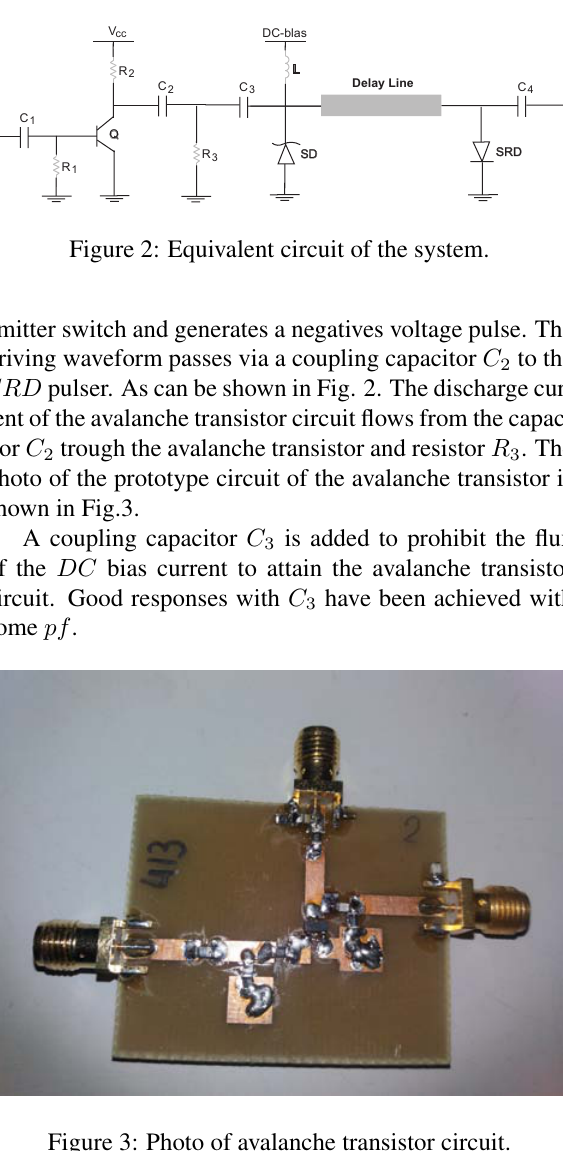
Figure 3: Photo of avalanche transistor